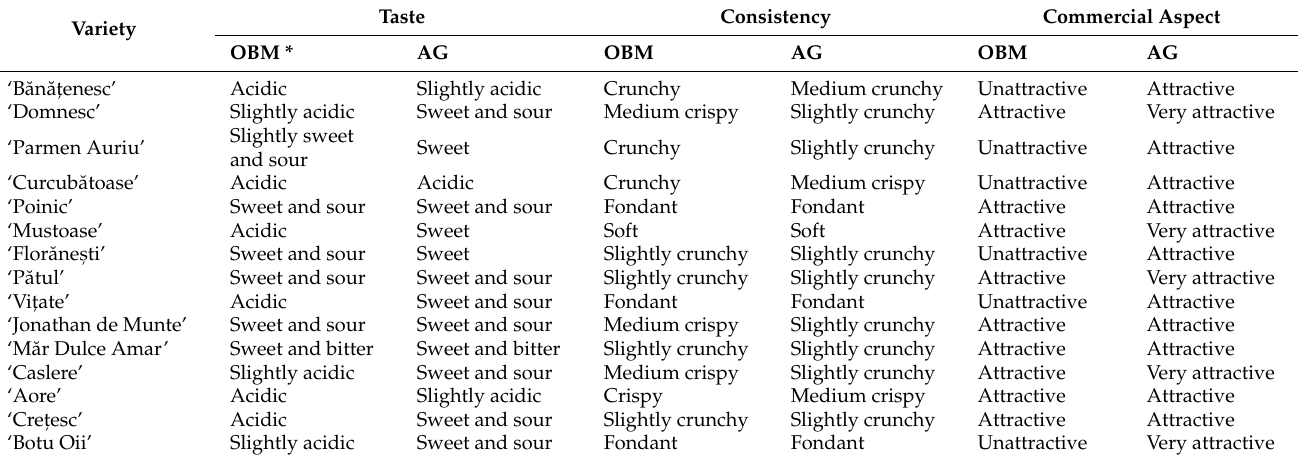
Table 6. Fruit taste, consistency and commercial aspect before and after